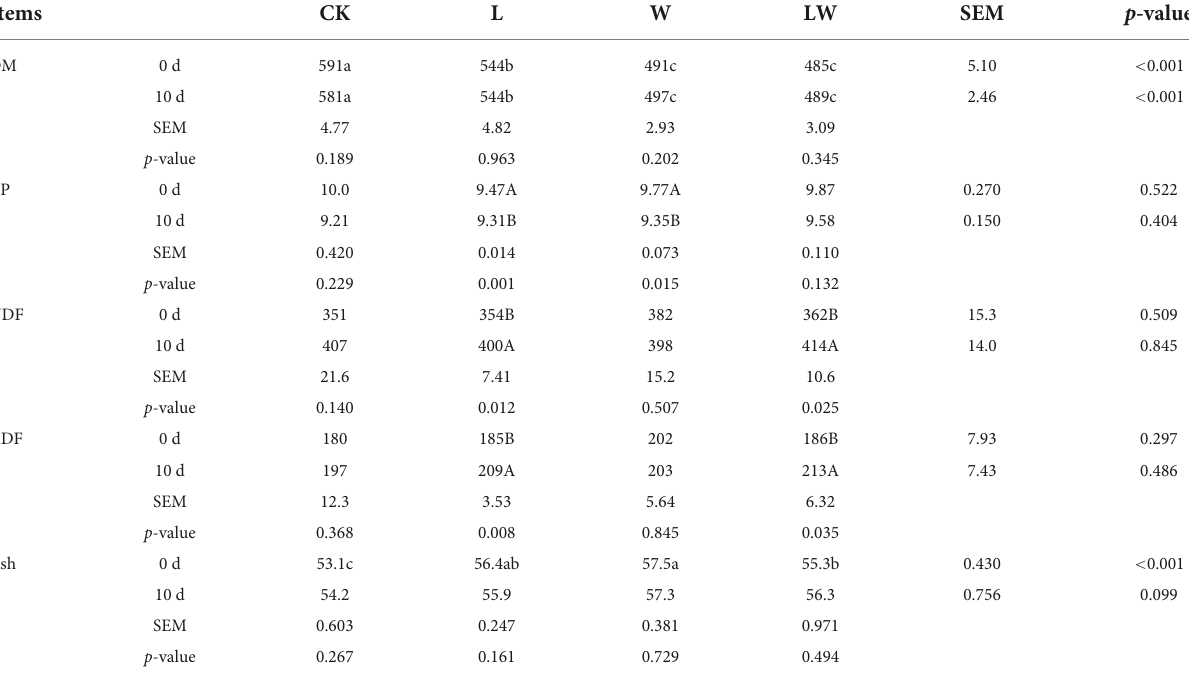
TABLE 5 The dry matter content (DM, g/kg) and nutritional compositions concentrations (g/kg DM) of Leymus chinensis silages ( n = 3).